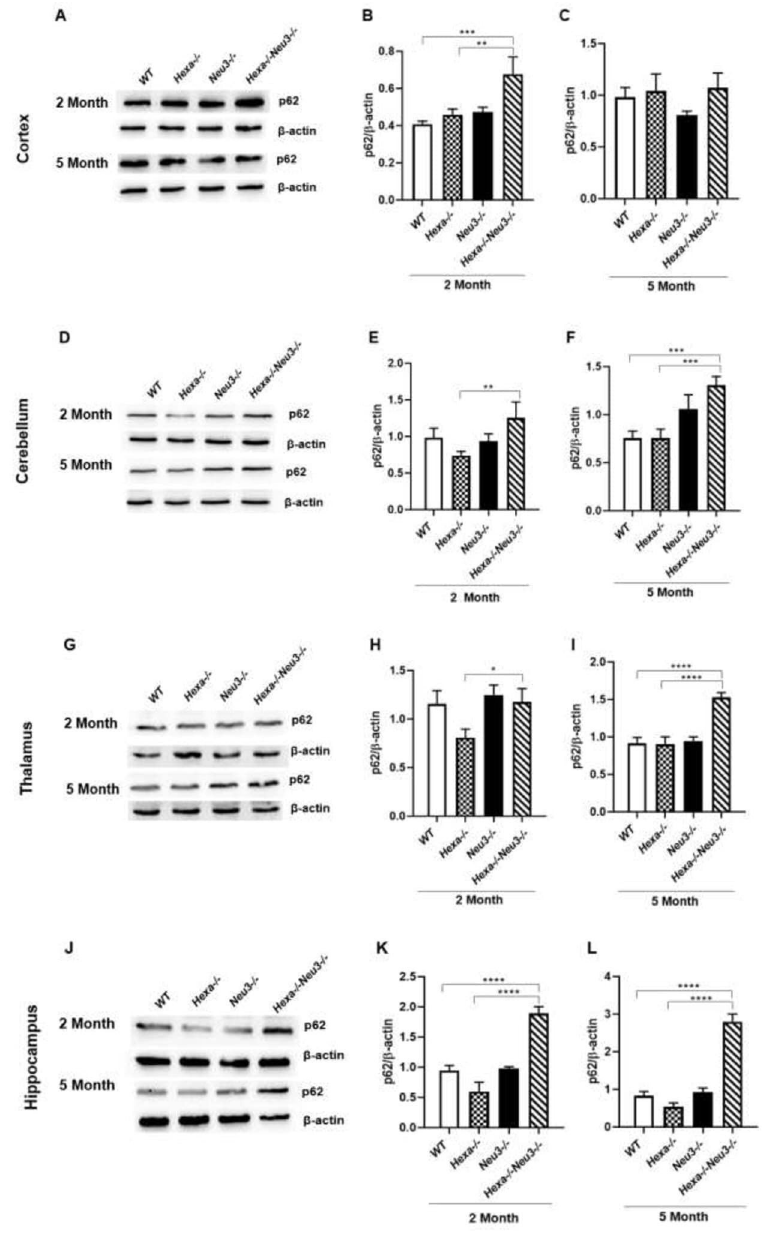
Fig 7. Immunoblot images and densitometric analysis of anti-p62 in the cortex (A-C), cerebellum (D-F), thalamus (G-I), and hippocampus (J-L) of 2- and 5-month-old WT , Hexa-/- , Neu3-/- , Hexa-/-Neu3-/- mice. β -actin was an internal control. Band intensities were determined by ImageJ and p values were determined by One-way-ANOVA analysis by GraphPad. Data are reported as mean ± SEM (n = 3; � p < 0,05, �� p < 0,025, ��� p < 0,01, ���� p < 0,001). mucopolysaccharidosis type IIIA (MPS-IIIA) [6]. Here, we demonstrated that both mRNA and protein levels of Beclin-1 decreased in the hippocampus and cerebellum of 5-month-old Hexa-/-Neu3-/- mice (Figs 1B, 2F and 2L). In parallel, the lower expression of Atg9 was detected in the cortex (Fig 1D), cerebellum (Fig 1H), and thalamus (Fig 1L) of 5-month-old Hexa-/-Neu3-/- mice. These results indicate an alteration in autophagic pathway initiation.